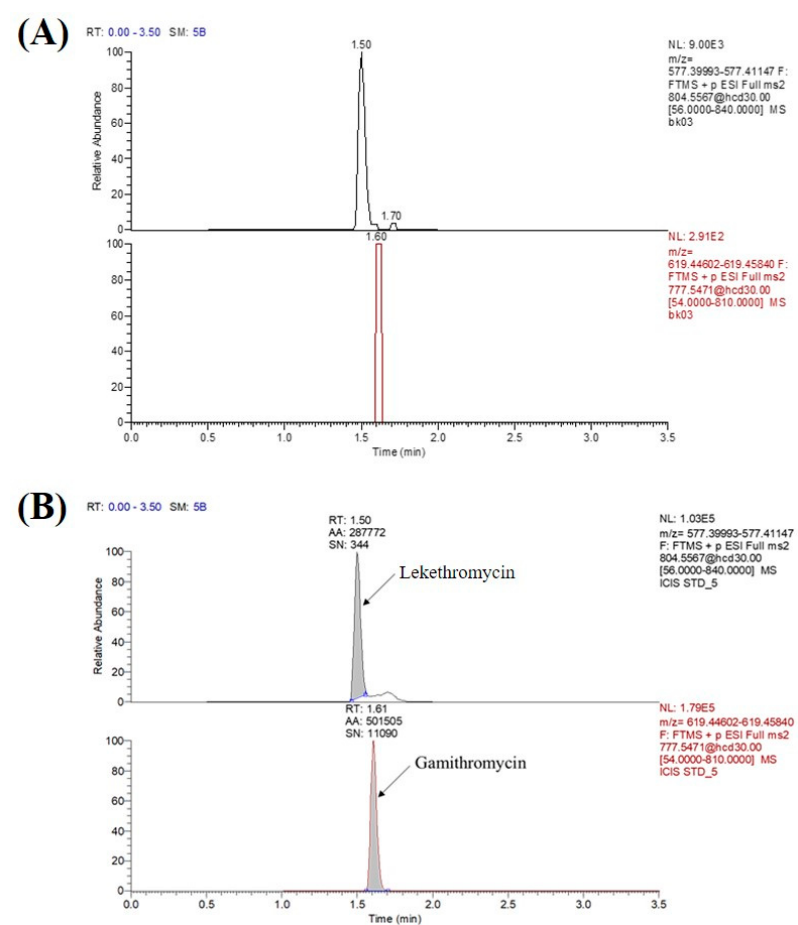
Figure 3. Chromatograms of lekethromycin and internal standard in blank rat plasma ( A ) and plasma spiked at lower limit of quantification (LLOQ) level ( B ).